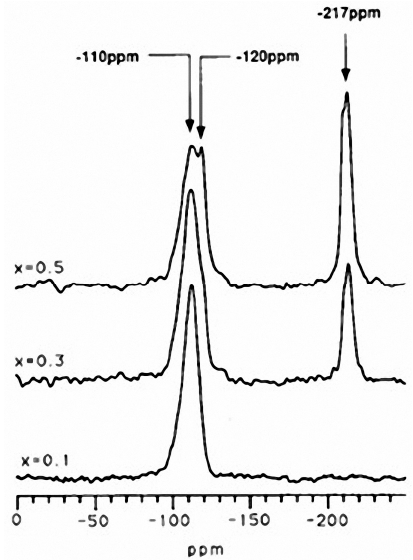
Figure 5. 29 Si MAS-NMR spectra for H 3 PO 4 -prepared gels heat treated at 200 ◦ C for 10 h. Adapted with permission from [70]; Copyright 1992 Copyright Elsevier.